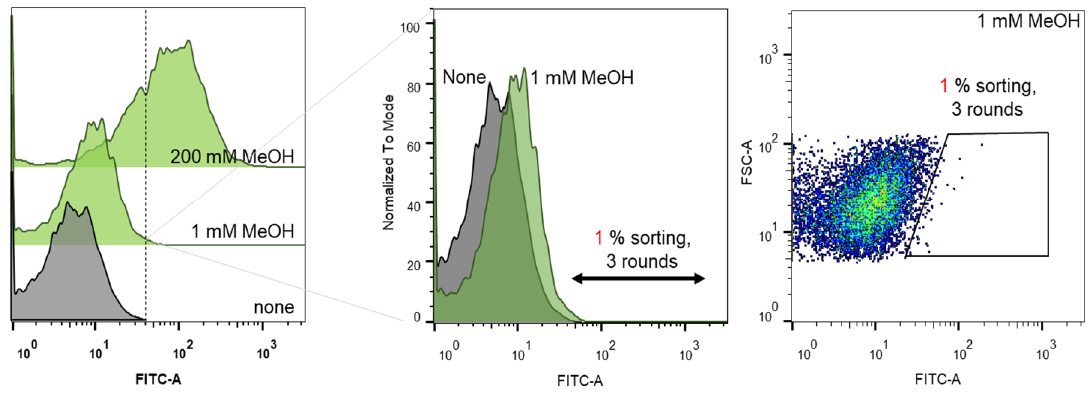
Figure 2. Flow cytometric analysis of cells harboring the Lxmdh mutant library at different concentrations of methanol, i.e., 0, 1 and 200 mM.